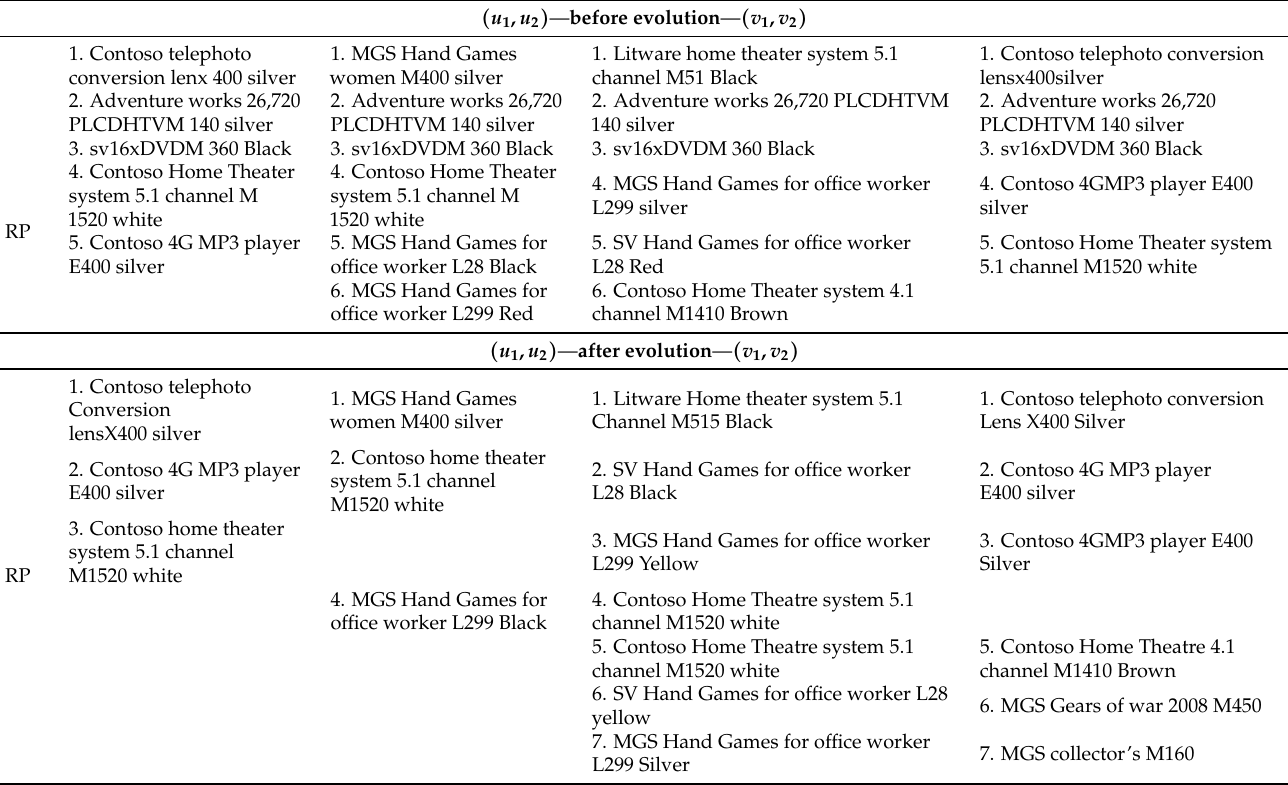
Table 7. Ontology reasoning recommendation before and after ontology